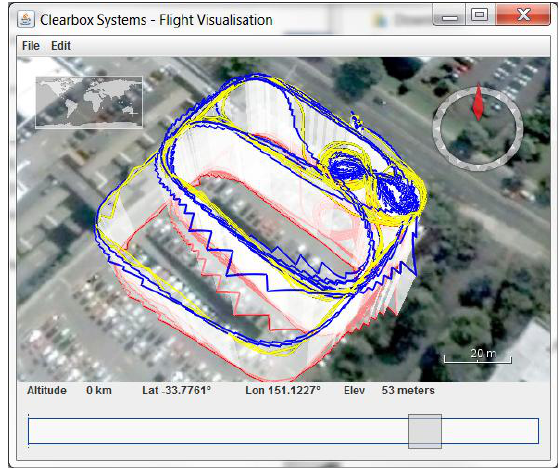
Figure 3 - Uncompensated GNSS latency.